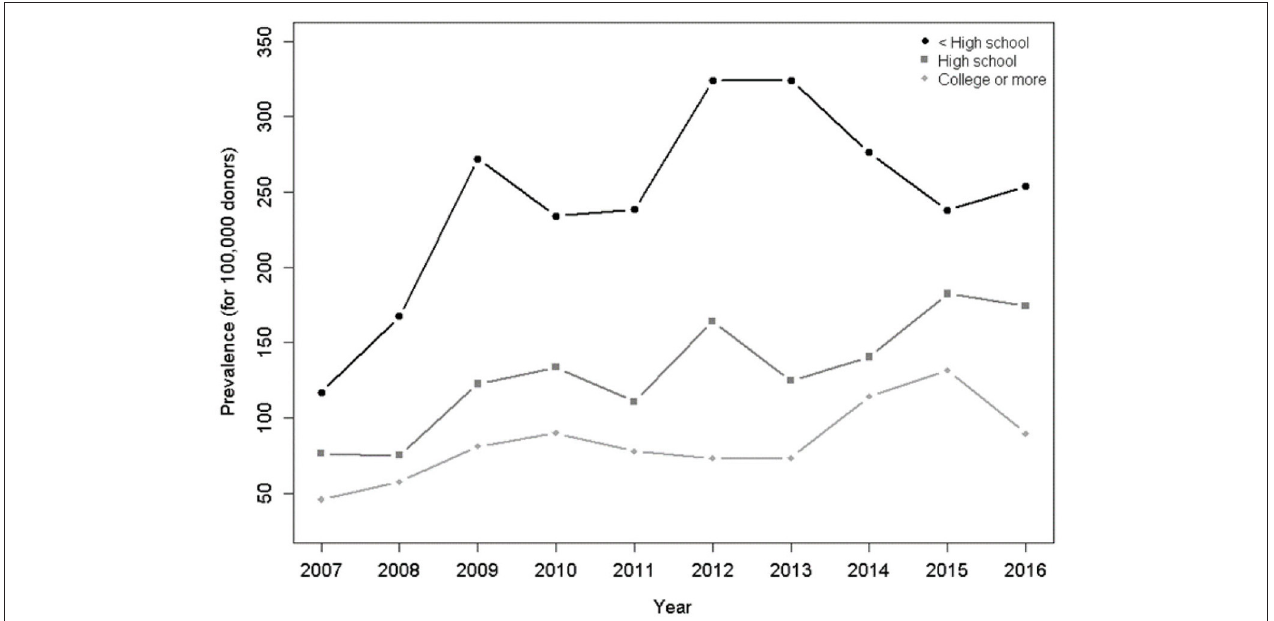
FIGURE 6 | Prevalence per 100,000 donors per year and skin color. There was a significant increasing trend for blacks ( p = 0.023) and whites ( p < 0.001) in the Poisson model.